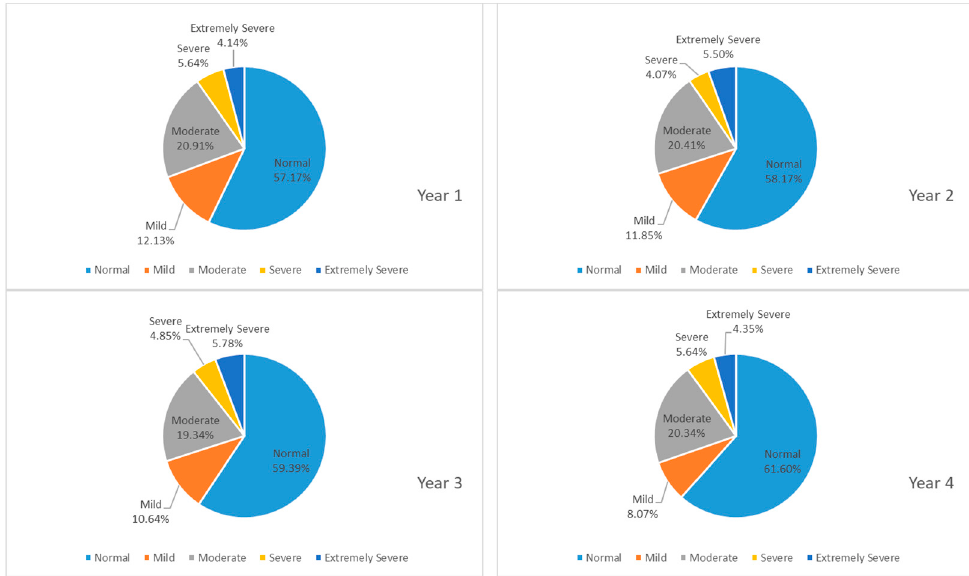
Figure 3. Proportion of participants whose answers on the DASS-21 indicated a normal, mild, moderate, severe or extremely severe amount of anxiety across years.